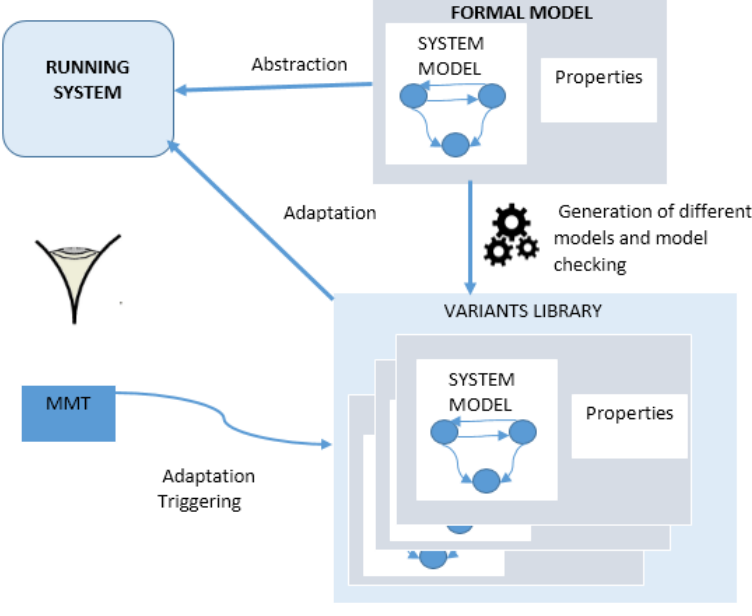
Figure 2. Model-based diversity